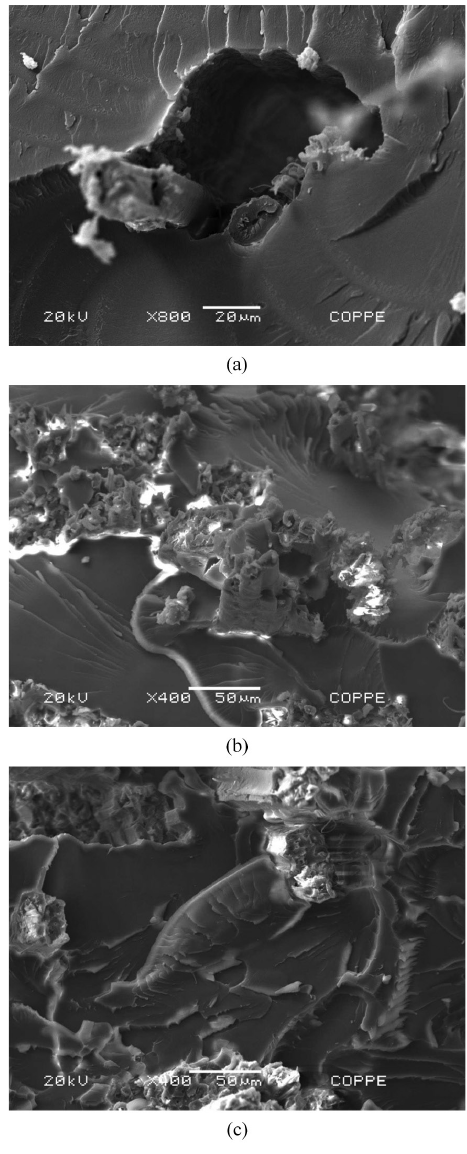
Figure 9. SEM fractographs of bend tested epoxy matrix composites reinforced with (a) 10 vol%; (b) 20 vol% and (c) 30 vol% of malva